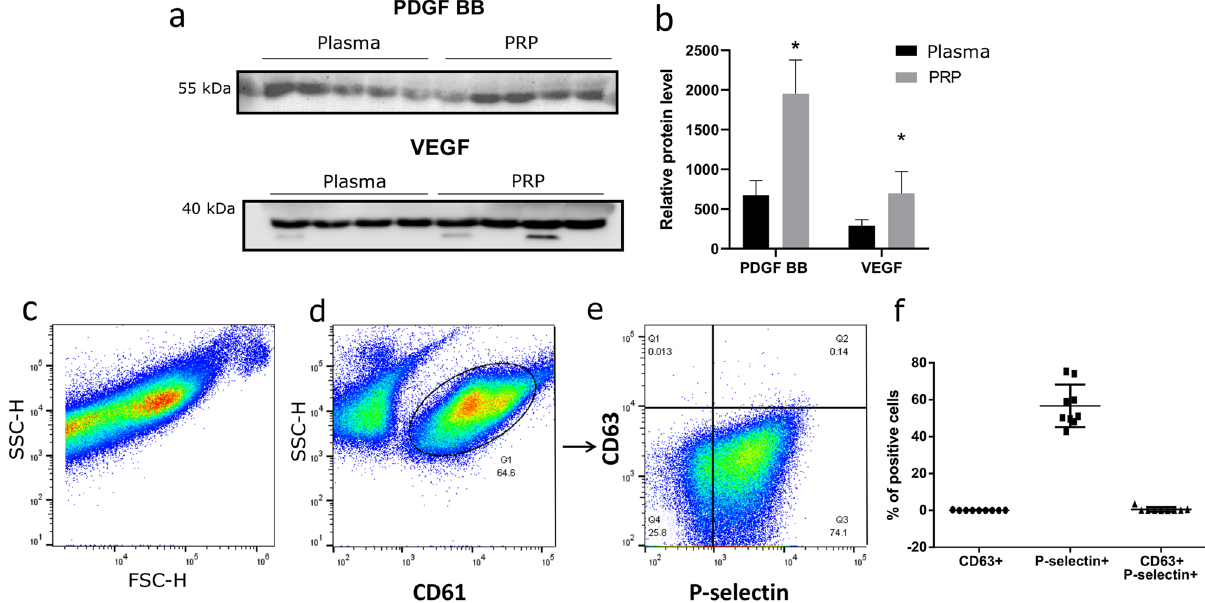
Figure 2. Immunochemical characterization of PRP. ( a) Images of western blotting membranes stained with specific antibodies to PDGF-BB and VEGF, representing ordinary plasma and PRP. ( b) relative levels of PDGF-BB and VEGF in ordinary plasma and PRP, normalized to the total protein content; * p < 0.05. ( c , d and e) representative flow cytometry dot plots of forward vs side scatter (FSC vs SCC) and SCC vs CD61 gating for CD63 vs P-selectin, quadrant axes set according to staining control. ( f) percentages of positively stained cells. Software: ( a) Image Lab Software RRID: SCR_014210, ( b,f) GraphPad Prism RRID: SCR_002798, ( c-e) BD CellQuest Pro RRID: